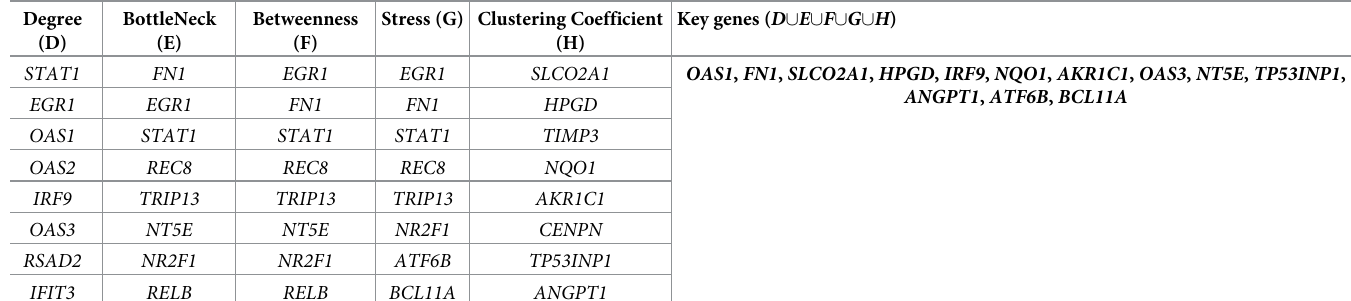
Table 2. Selection of KGs by taking the union of five-sets of top-ranked 8 genes produced by five topological measures with the PPI